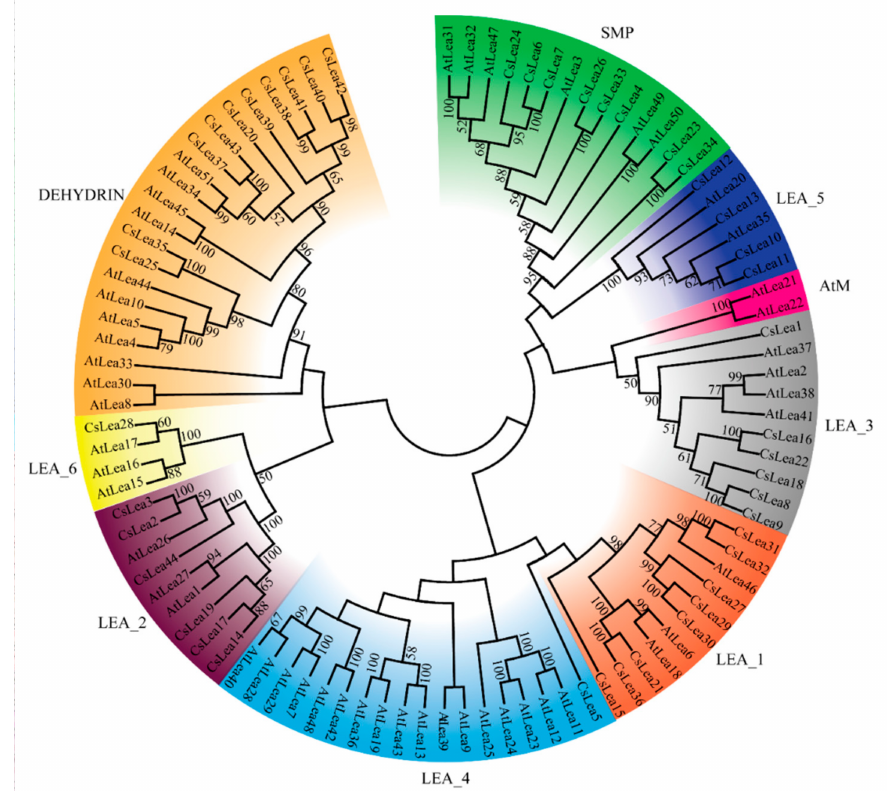
Figure 1. Phylogenetic analysis of C. songorica LEA proteins. Full-length amino acid sequences of the 44 CsLEA proteins were analyzed using the unrooted method in the ClustalW